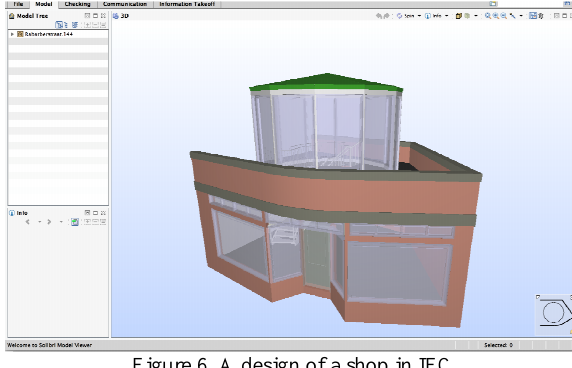
Figure 6. A design of a shop in IFC